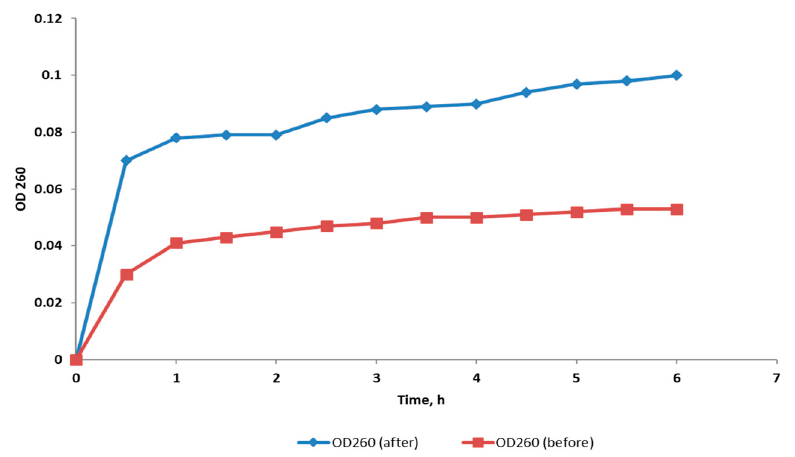
Figure 3. A chart showing the increase in the release of the material absorbing at 260 nm (indicating a decrease in the membrane integrity) from a representative S. enterica isolate after treatment with CRME (32 µg/mL).